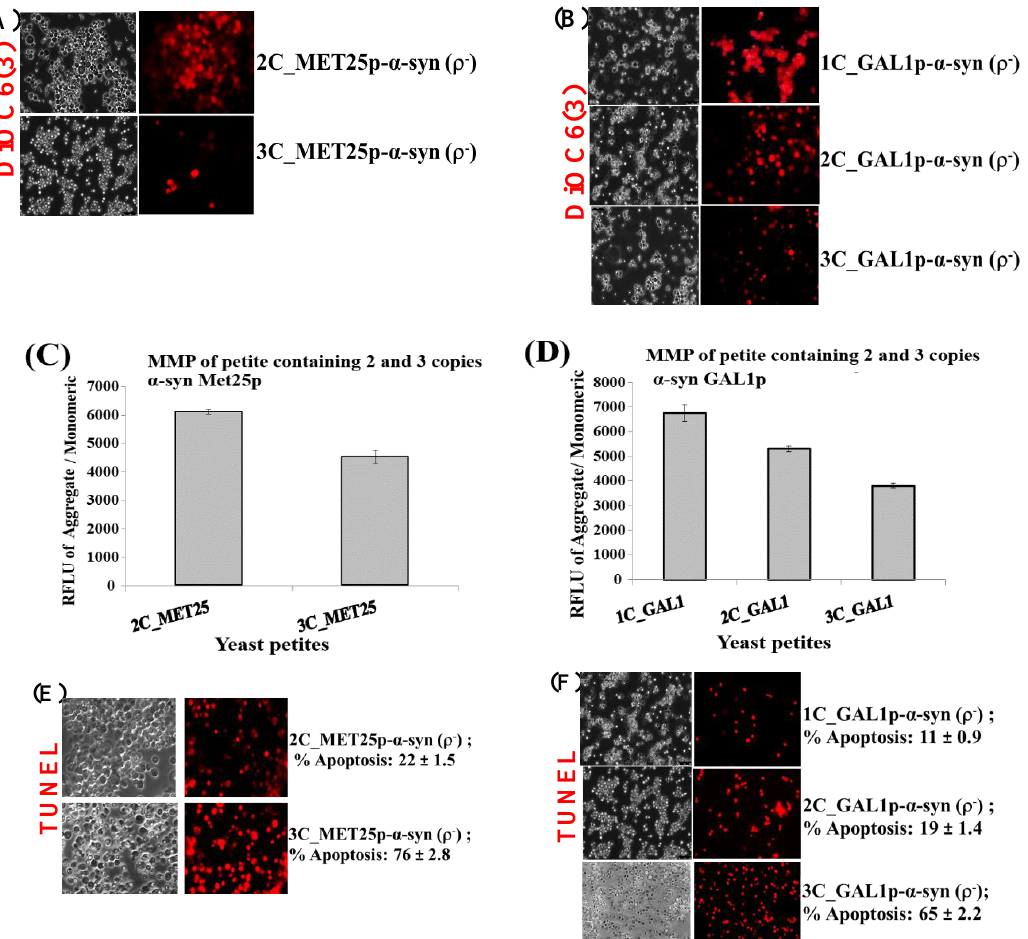
Figure 3. ( A , B ) Microscopic images (×400) of staining of ρ - petite transformants, that bear chromosomally integrated α-syn-containing plasmids, with the dye DiOC6(3) that detects MMP in live cells. The images are representative images (×400) of cells. ( C , D ) Quantification of relative MMP of yeast cells expressing 2 and 3-copies of α-syn from MET25 p and 1–3-copies of α-syn from GAL1 p, using the JC-10 dye ( p < 0.1). ( E , F ) Microscopic images (×400) of nuclear DNA fragmentation, as observed using the TUNEL assay, in yeast cells expressing 2 and 3-copies of α-syn from MET25 p and 1–3-copies of α-syn from GAL1 p. The images are representative images of cells. The data in figures ( C , D ) represent mean ± S.D. of three independent experiments ( p < 0.1; two-tailed t -test). The left-hand side pictures in ( A , B , E , F ) show phase-contrast microscopy pictures (×400) of yeast cells. Post Hoc Newman-Keuls test, after a significant one-way ANOVA test, indicated a significant difference p < 0.001 between strains expressing 2 and 3-copies of α-syn from MET25 p, and between 1 and 2-copies and 3-copies of α-syn from GAL1 p.